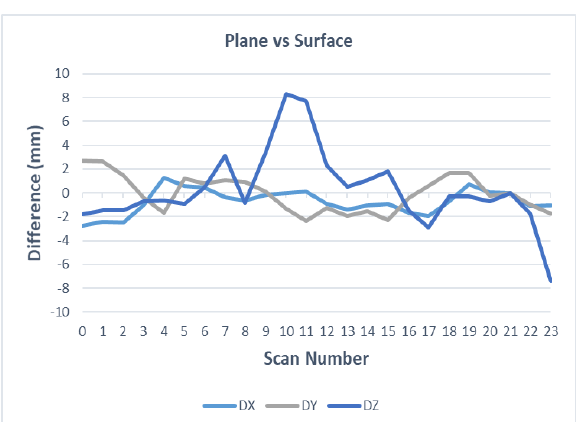
Figure 12. Case Study 1: differences on the computed scan locations between the plane- and surface-based methods.